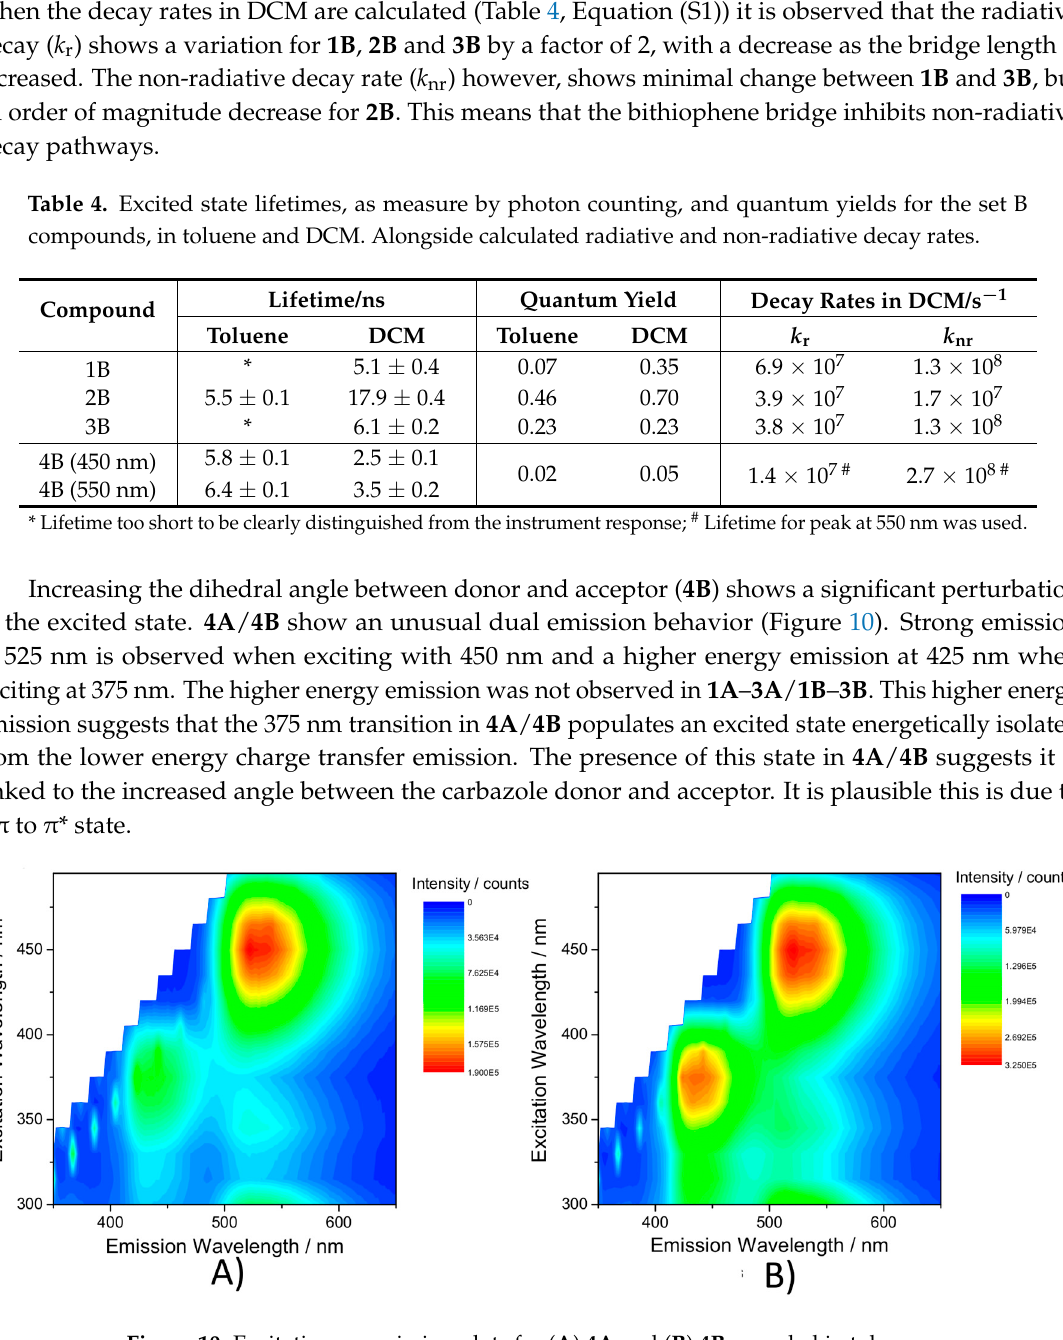
Figure 10. Excitation vs emission plots for ( A ) 4A and ( B ) 4B recorded in toluene.